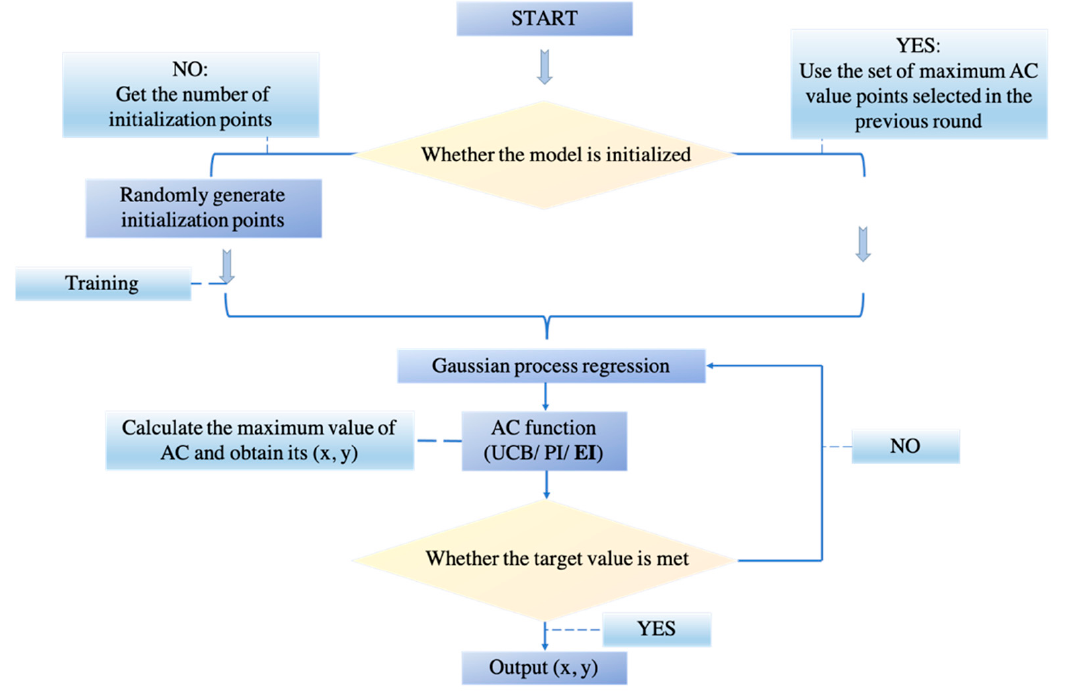
Figure 8. The pipeline of Bayesian Optimization.